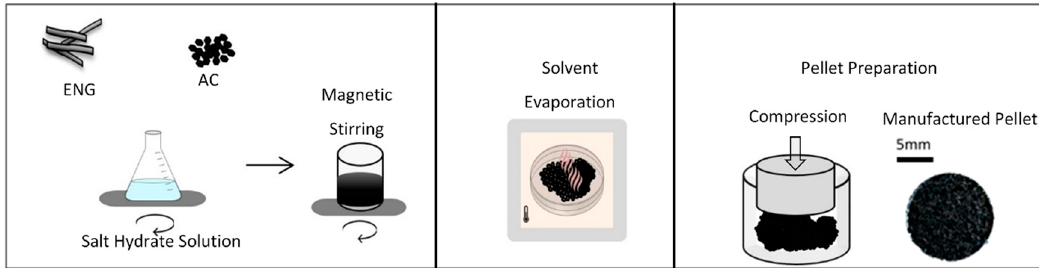
Figure 1. Manufacturing process for the thermochemical heat storage pellets.